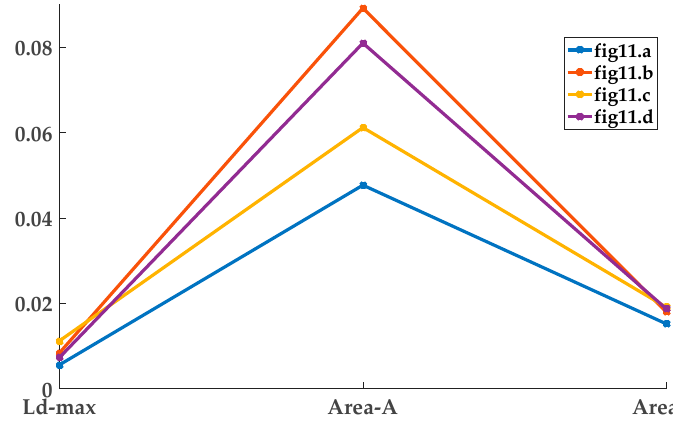
Figure 12. Evaluation chart.